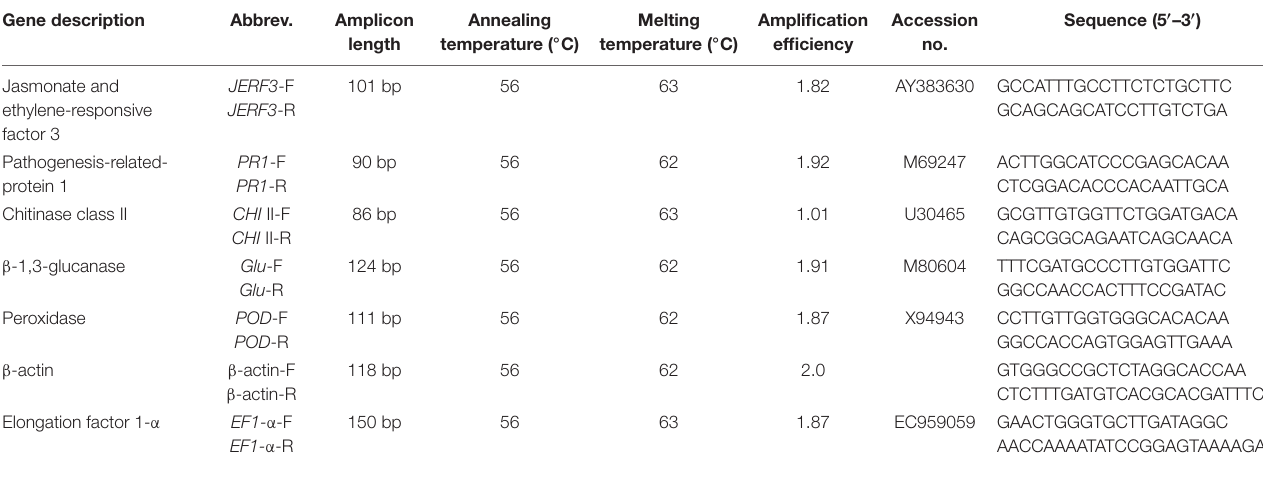
TABLE 1 | Primer sequences of the genes studied in the qPCR. Gene description